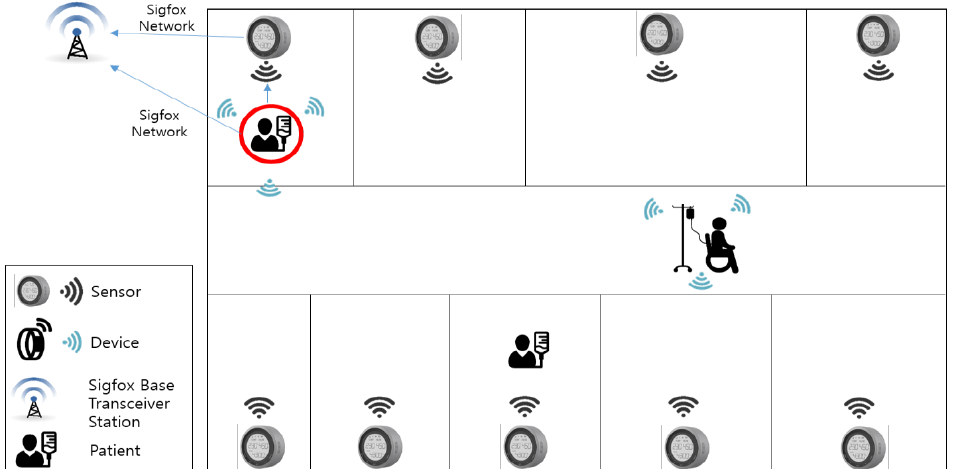
Figure 6. Sigfox Network Field Setting for Monitoring Patient Location.